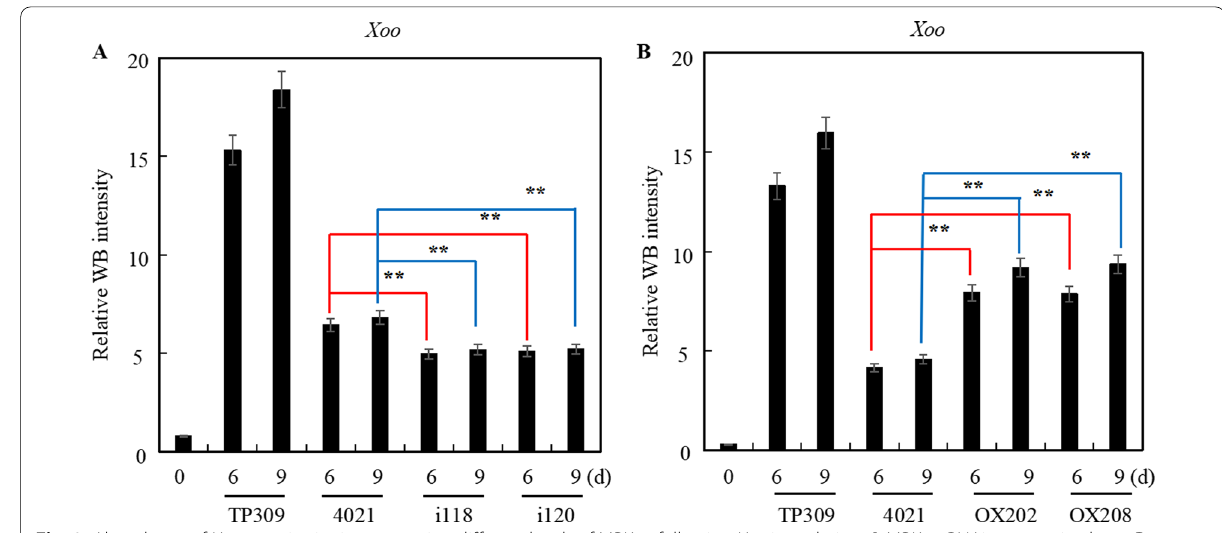
Fig. 8 Abundance of Xoo proteins in rice expressing different levels of MPK17 following Xoo inoculation. A MPK17-RNAi transgenic plants. B MPK17-OX transgenic plants. Inoculated rice plants were cultivated at 31 ℃ (MPK17-RNAi transgenic rice) or 27 ℃ (MPK17-OX transgenic rice). The whole leaves were collected at 0, 6, 9 dpi, total proteins were isolated and separated by SDS-PAGE, then detected by anti- Xoo antibody (Additional file 1: Fig. S2). Protein signal were detected by Mini Chemiluminescent Imager and Sage Capture software. Lane 1D software was used to capture the signals of WB. Mean was calculated for three repeats. Error bars are standard deviation (SD). **denotes difference at p < 0.01 level. i118, i120: independent MPK17-RNAi transgenic lines; OX202, OX208: independent MPK17-OX transgenic lines; TP309: Japonica rice variety; 4021: homozygous transgenic TP309 line harboring the Xa21